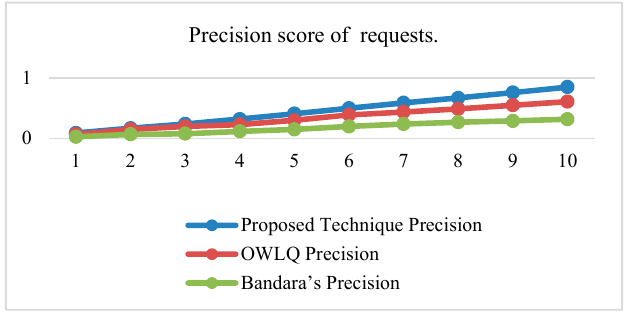
Figure 6. Precision of service requests.